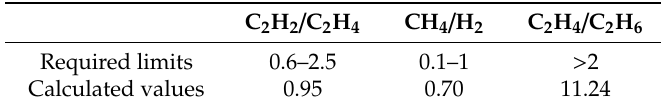
– – Table 9. The values of characteristic ratios required to determine the discharge of high energy as per the IEC 60599 Standard and the values calculated on the basis of measurement